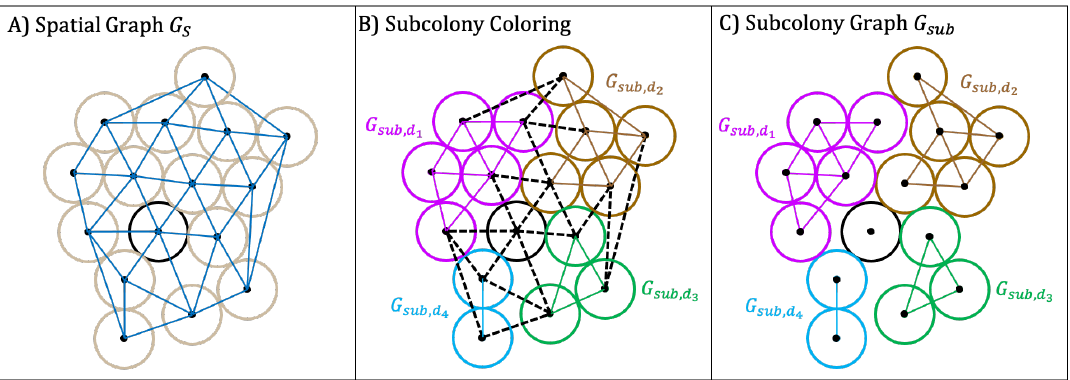
Figure 17. Constructing Subcolony Graphs. Subcolony graphs are constructed from partitions